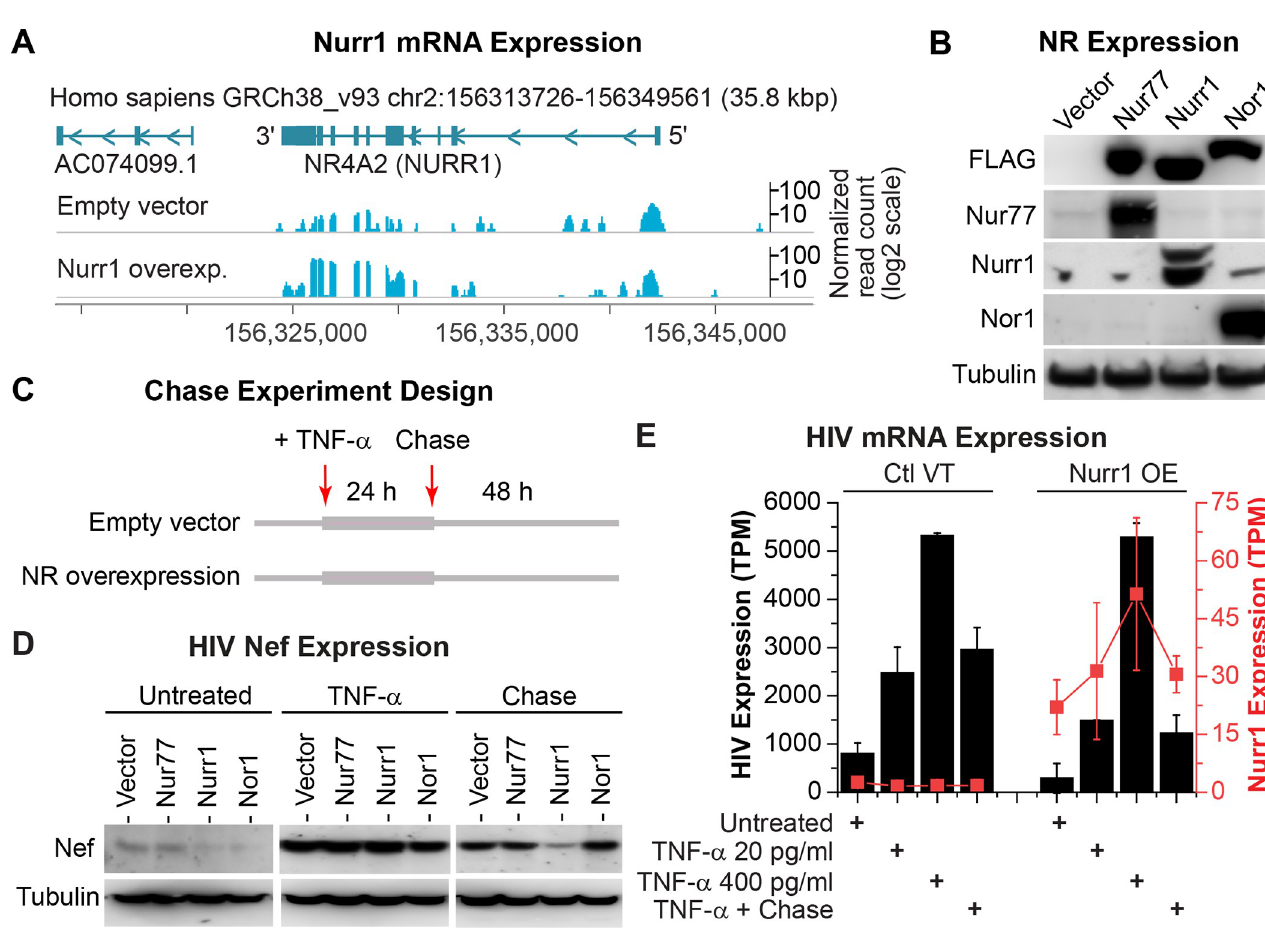
Fig 3. Overexpression of Nurr1 in HC69 cells enhances HIV silencing. A, RNA-Seq confirmation of overexpression (OE) of Nurr1 in HC69 cells. Sequence read histograms for the Nurr1 locus is shown for control (vector) and Nurr1 overexpression. Annotated genes for the shown locus are indicated on the top, and the position of the locus on chromosome 2 is shown both at the top and the bottom. A read scale for each row is shown on the right, with the values for the overexpression studies drawn on a log2 scale. B, Verification of Nur77, Nurr1, and Nor1 overexpression by Western blot analysis in HC69 cell lines stably expressing 3X-FLAG-tagged Nur77, Nurr1, and Nor1 respectively by using a mouse monoclonal anti-FLAG M2 antibody (Sigma, Cat# F1804) and the nuclear receptor specific antibodies described in Fig 2B . HC69 cells stably carrying the 3X-FLAG-empty vector were used as a reference for comparison. The level of β - tubulin was used as a loading control. Notably, the levels of endogenous Nur77 and Nor1 in HC69 cells were very limited. In contrast, Nurr1 was constitutively expressed in HC69 cells. C, Schematic depicting the TNF- α stimulation and chase studies. The four cell lines described in B were either untreated or treated with high dose (400 pg/ml) TNF- α for 24 hr. To examine HIV silencing, one set of TNF- α induced cells were used in a chase experiment by continuous culture of the cells in the absence of TNF- α for an additional 48 hr. The time points at which TNF- α is added or removed are shown by arrows on the top. D, Expression of HIV Nef protein in the different cell lines before and after TNF- α stimulation and at the end of the chase experiment was measured by Western blot analysis. The level of β -tubulin was used as a loading control. E, Expression level of HIV mRNA (black bar graph) and Nurr1 (red rectangles and lines) in transcripts per million cellular transcripts are shown for each of the treatment steps shown in panel C in both vector-infected cells (on the left) and Nurr1 overexpressing cells (on the right half of the graph). For the 24 hr TNF- α stimulation step, both a low dose (20 pg/ml) and a high dose (400 pg/ml) are used. The values shown are the average of three replicate RNA-Seq samples with two standard deviations as error bars. The expression values for HIV and Nurr1 are shown on Y axes to the left and right,